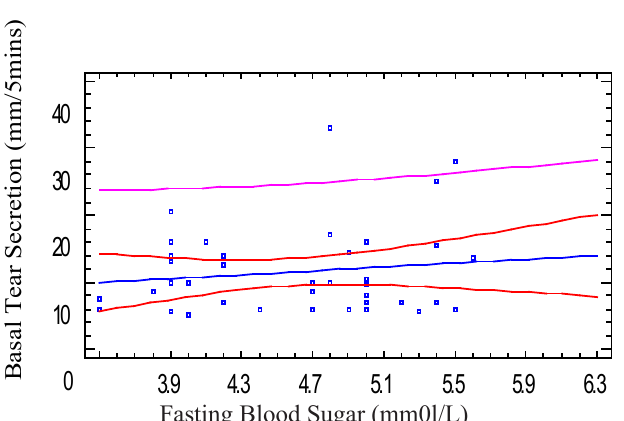
Figure 5: Relationship between fasting blood sugar and basal tear secretion in the control group.